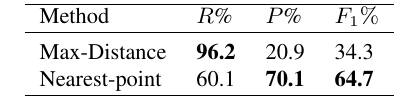
Table 1: Accuracy assessment of moving object detection at point level using different methods. Better values are in bold.